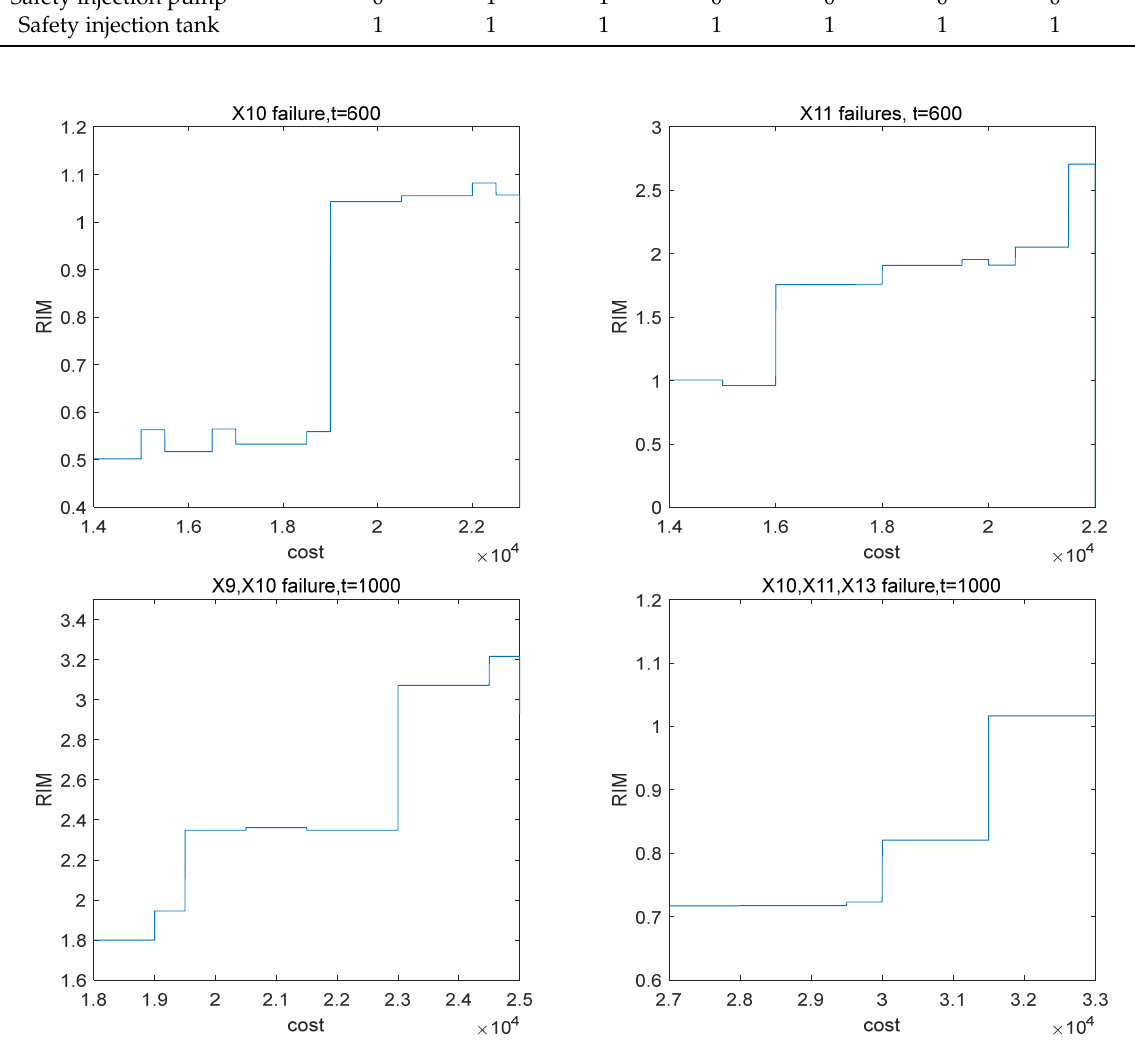
Figure 4. RIM when total maintenance cost changes.